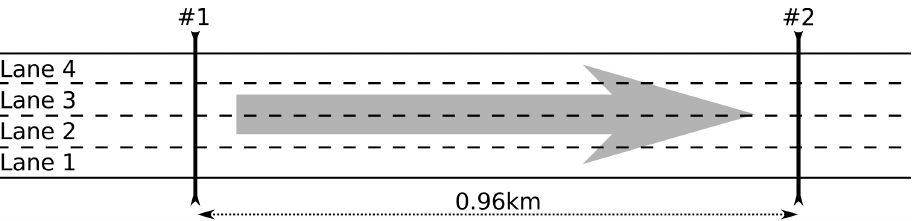
Figure 2. Traffic detectors #1 and #2 chosen in the segment of the I-580 freeway in California, USA. Data from detector #1 were used as a left boundary condition for modeling, and data from the downstream detector #2 were used for the verification of modeling